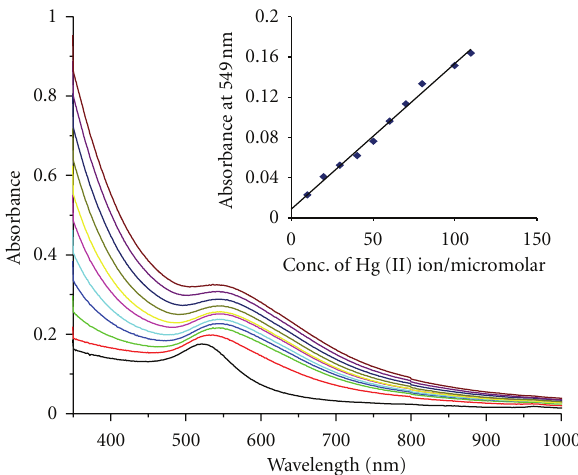
Figure 5: UV-vis spectra of PVP stabilized AuNPs (pH = 12) before and after each addition corresponding to 10 µ M Hg 2+ ion; Inset. Calibration plot of intensity of absorption value versus Hg 2+ ion concentrations for each addition of 10 µ M.